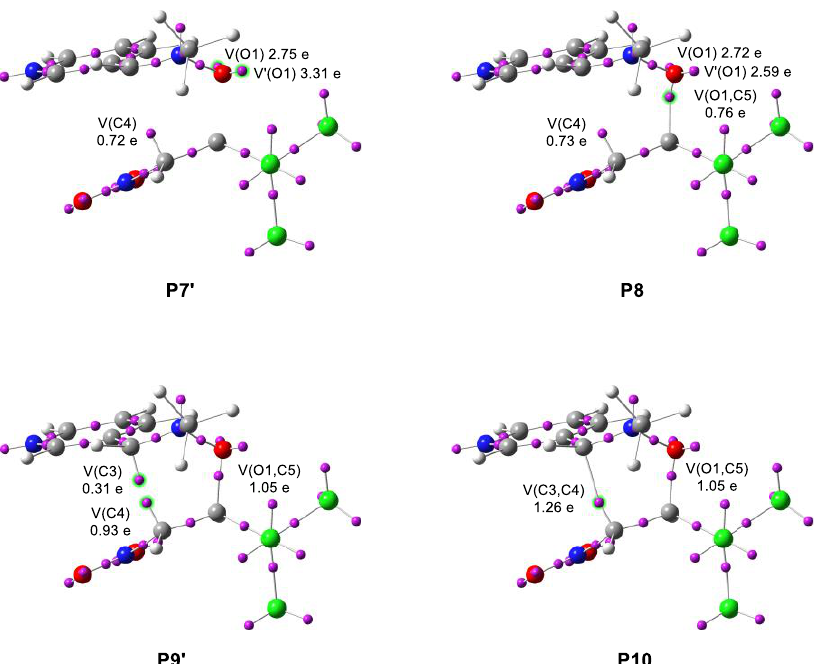
Figure 3. ELF attractor positions of the structures involved in the C-O and C-C bond formation along the experimental reaction path of 3,3,3-trichloro-1-nitropropene 2a and nitrone 1. The prime symbol marks the last structure of the corresponding BET phase.